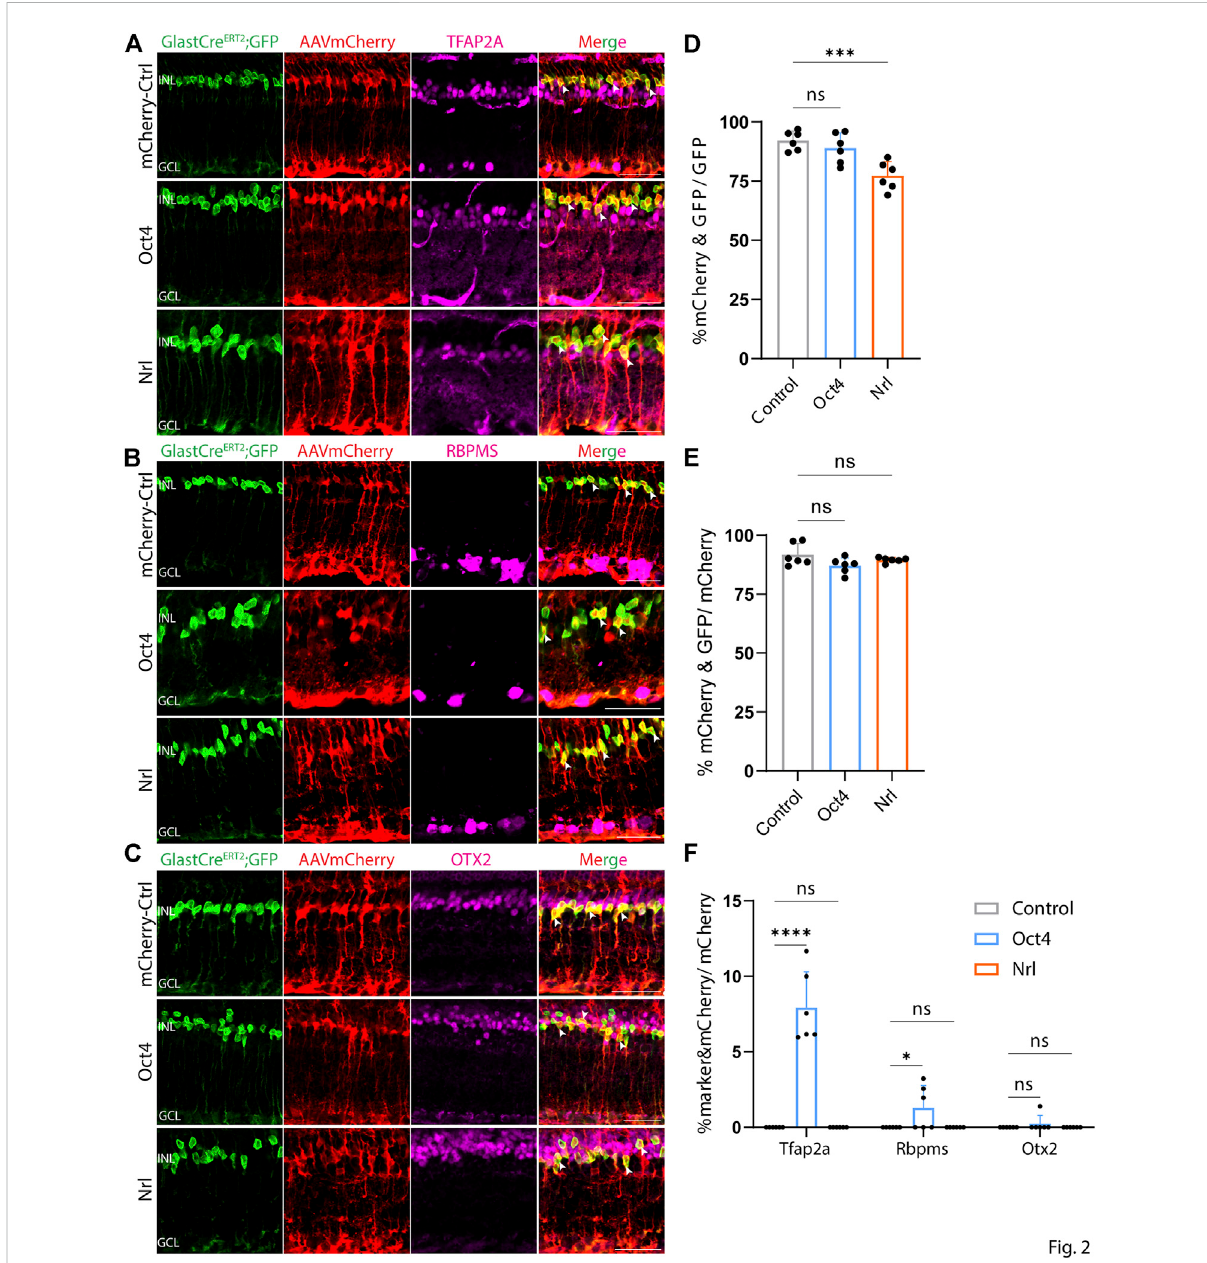
FIGURE 2 GFAP promoter constructsexpressing mCherry, Nrl,and Oct4 show strong Müller glia-speci fi cexpression. Representative immunostaining for GFP, mCherry and 3 neuronal markers: (A) Tfap2a, (B) Rbpms, and (C) Otx2 expression in the retinas collected 21 days post GFAP AAV infection. GFAP-mCherry, GFAP-Oct4-mCherry and GFAP-Nrl-mCherry showed almost complete colocalization of construct-derived mCherry and Müller glia-speci fi c Sun1-GFP. White arrowheads indicate co-labeled mCherry+/GFP + cells. Little to no mCherry expression in amacrine, retinal ganglion and bipolar cells is observed in these GFAP AAV constructs. Quanti fi cation of transduction ef fi ciency (mCherry+ & GFP + cells/GFP + cells) (D) and transduction speci fi city (mCherry+ & GFP + cells/mCherry + cells) (E) . Quanti fi cation of mean percentage ±SD of marker & mCherry+/GFP cells: Tfap2a+ & mCherry+/GFP + cells (in INL and GCL), Rbpms+ & mCherry+/GFP + cells (in GCL) and Otx2+&mCherry+/GFP + cells (in INL) (F) . Signi fi cance was determined via one-way ANOVA or two-way ANOVA with Dunnett ’ s test: *** p < 0.001, **** p < 0.0001. Each data point in the bar graphs was calculated from an individual retina ( n = 6). INL, inner nuclear layer; GCL, ganglion cell layer. Scale bar = 40 μ